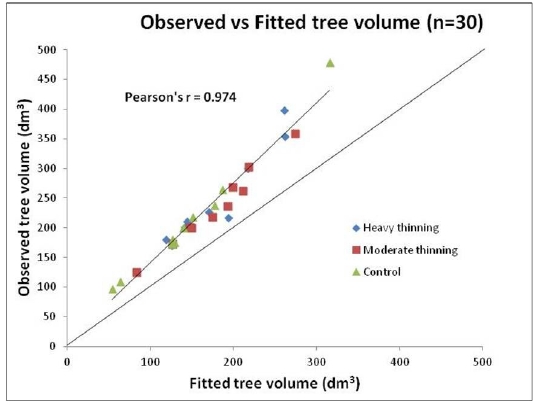
Figure S1. Merchantable tree volume estimated compared with tree volume